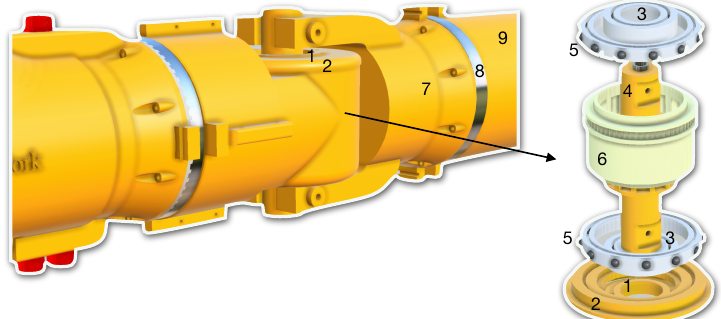
Figure 6. Body parts comprising a segment: 1. Inner joint housing lid; 2. Outer joint housing lid; 3. Zirconia ceramic bearing; 4. Driven shaft; 5. Stainless bearing; 6. Driving shaft; 7. Electronic housing; 8. Stainless male/female rings; 9. Servo housing.